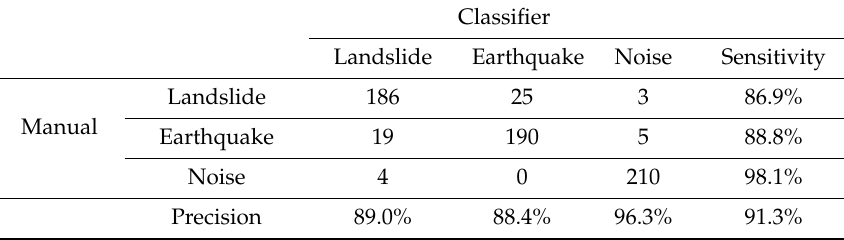
Table 3. Confusion matrix for the classifier created using the time domain and the frequency domain